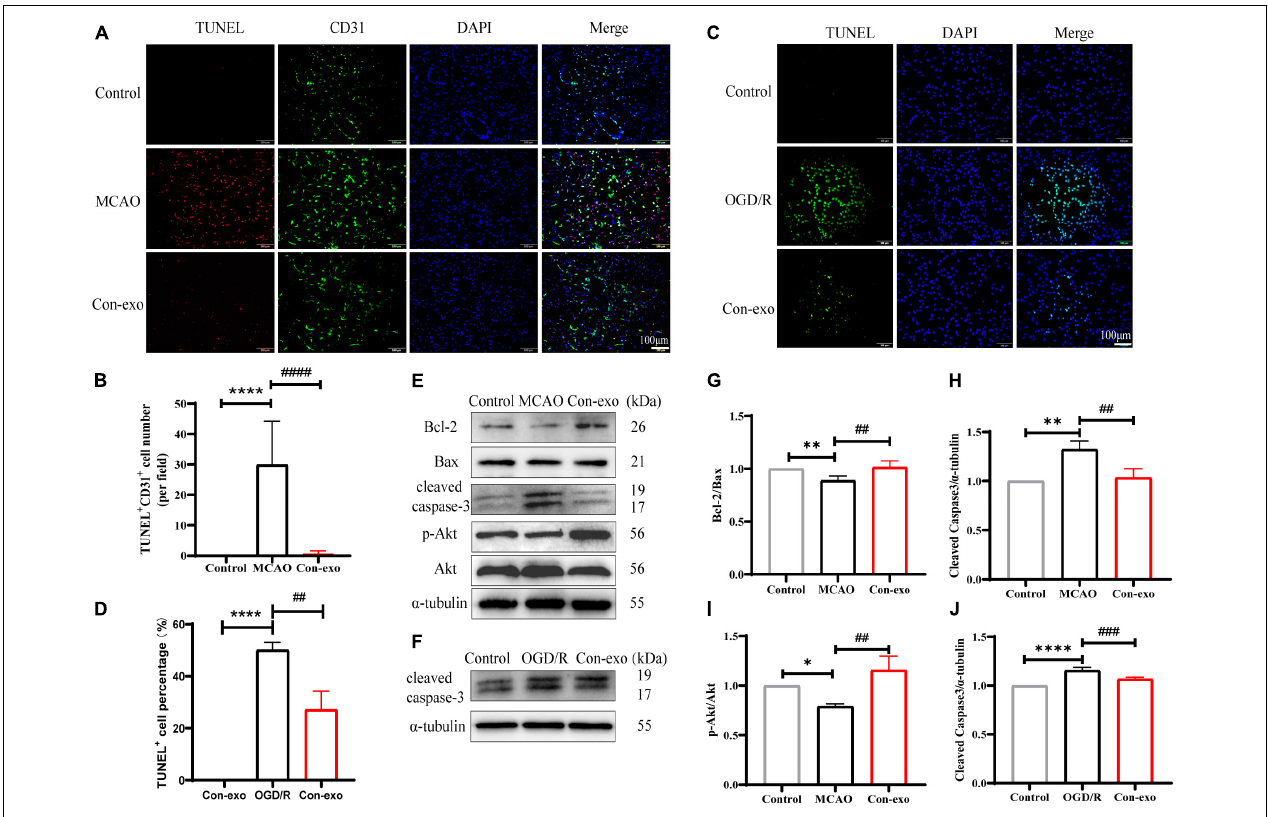
FIGURE 4 | Serum exosomes alleviate apoptosis in vivo and in vitro . (A) The representative images of Con-exo on the endothelial cell apoptosis (TUNEL + CD31 + cells) in striatum was evaluated by terminal deoxynucleotidyl transferase (TdT)-mediated dUTP nick-end labeling (TUNEL) staining combined with CD31 immunofluorescence staining. (B) The statistical analysis of the effect of Con-exo on TUNEL + CD31 + cell number in ischemic striatum. (C,D) The representative images and analysis of Con-exo on the apoptosis in oxygen-glucose deprivation/reoxygenation (OGD/R) stimulated bEND.3 cells. (E,F) The effect of Con-exo on the expression of cleaved caspase-3, Bcl-2, Bax, p-Akt, and Akt in the ischemic cortex (E) and OGD/R stimulated bEND.3 cells (F) . (G–I) The statistical analysis of cleaved caspase-3 (G) , Bcl-2/Bax (H) , and p-Akt/Akt (I) in the ischemic cortex and cleaved caspase-3 (J) in bEND.3 cells challenged by OGD/R. ∗ P < 0.05, ∗∗ P < 0.01, ∗∗∗∗ P < 0.0001 vs. control, ## P < 0.01, ### P < 0.001, #### P < 0.0001 vs. MCAO or OGD ( n =